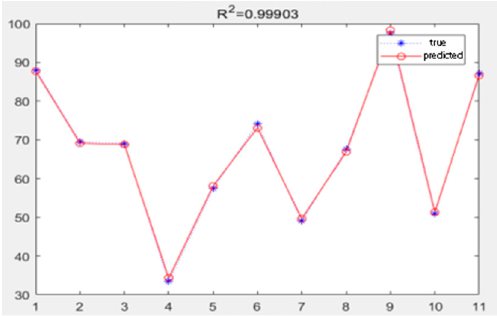
Figure 5. The test set distance prediction results are